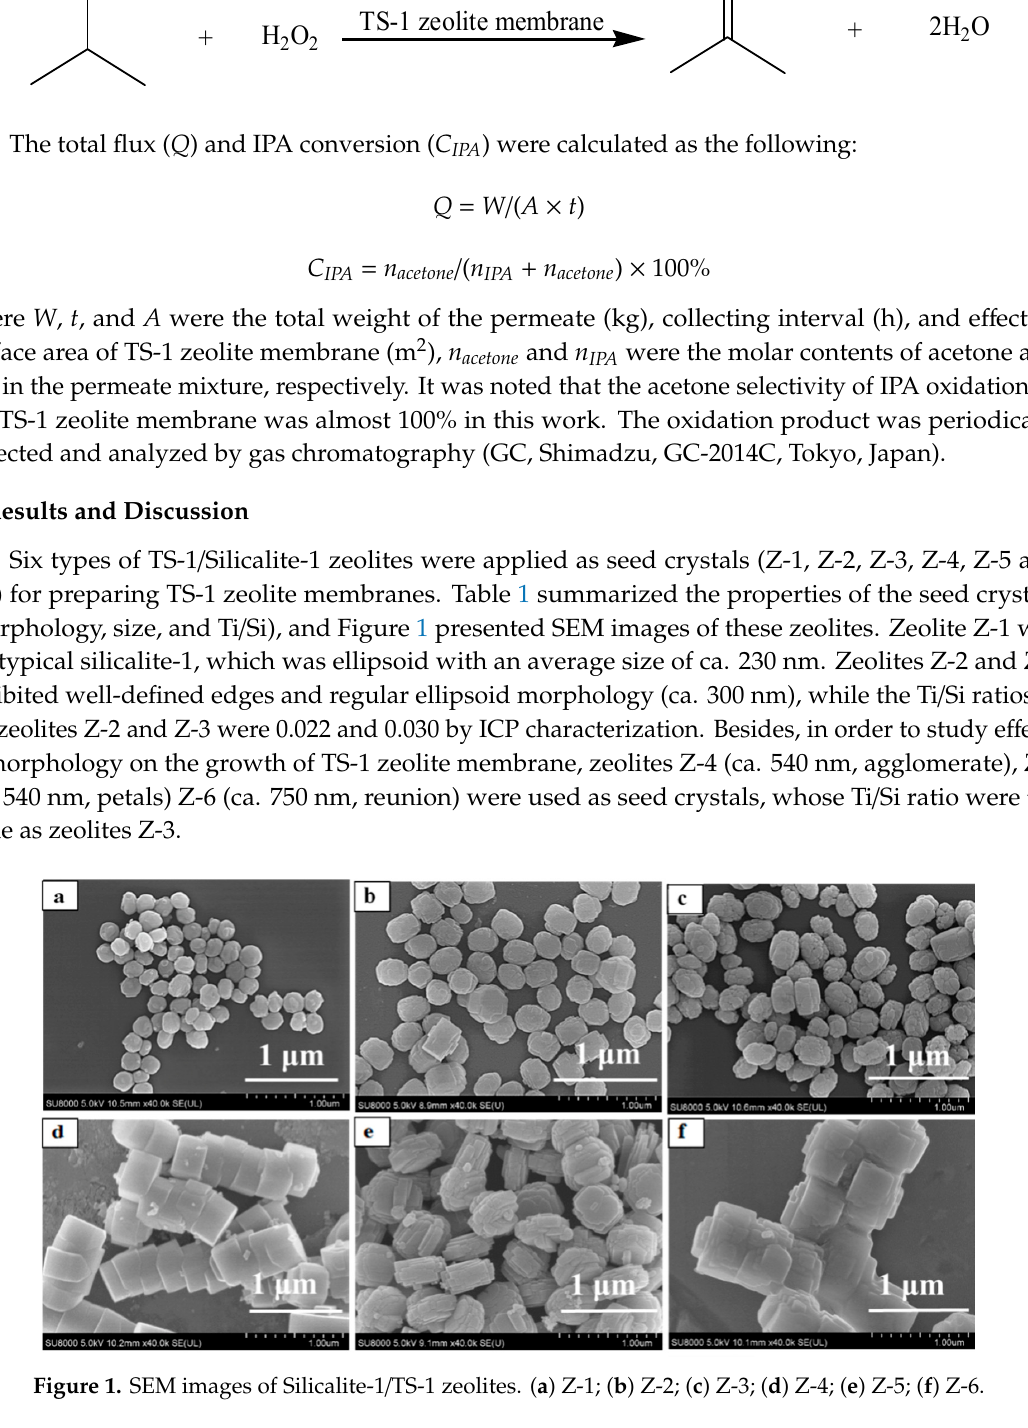
Figure 1. SEM images of Silicalite-1/TS-1 zeolites. ( a ) Z-1; ( b ) Z-2; ( c ) Z-3; ( d ) Z-4; ( e ) Z-5; ( f )